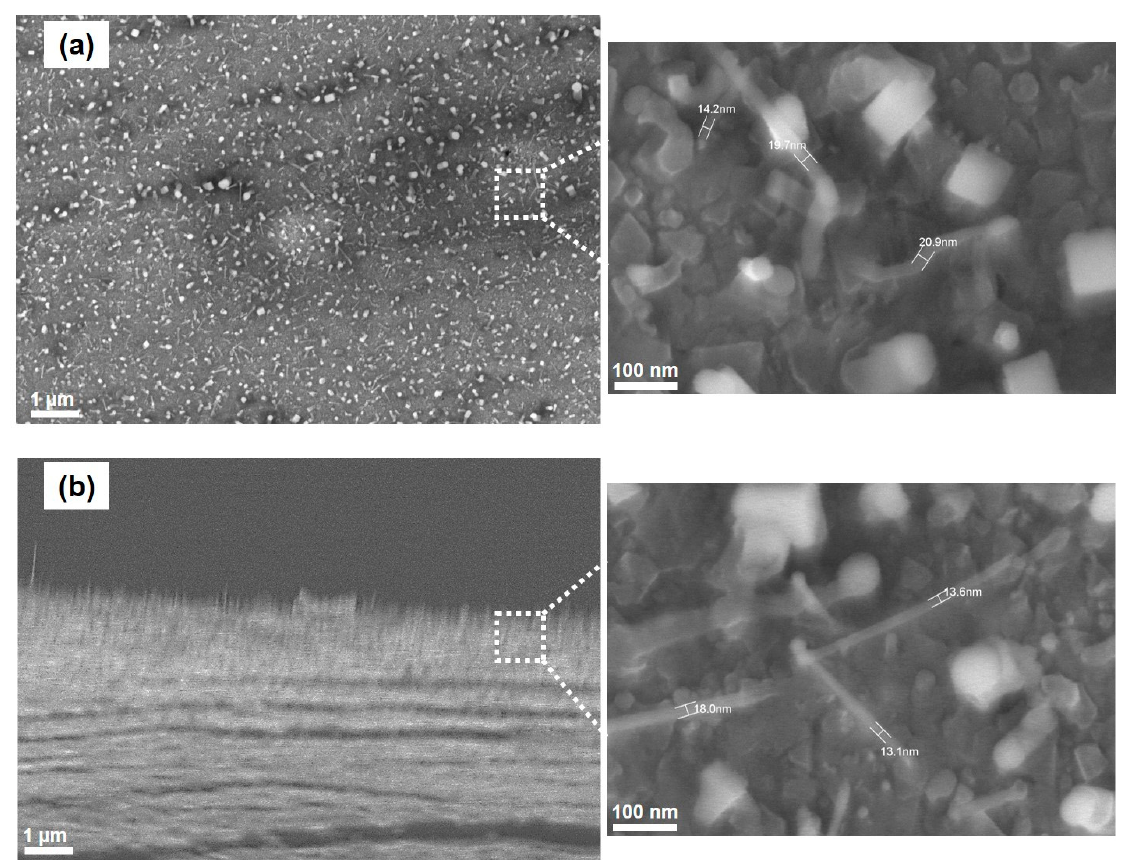
Figure 10. SEM images of formed CNTs at 850 °C for 2 min: ( a ) vertical direction and ( b ) horizontal direction.